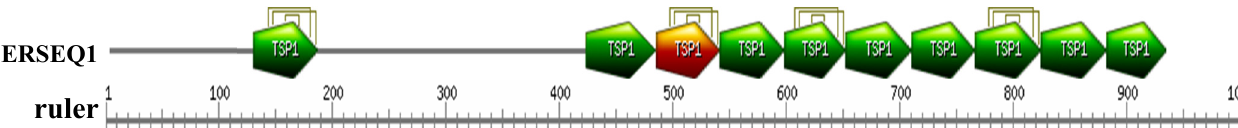
Figure 2. Domain analysis of ADAMTS13-like from A. japonicus .